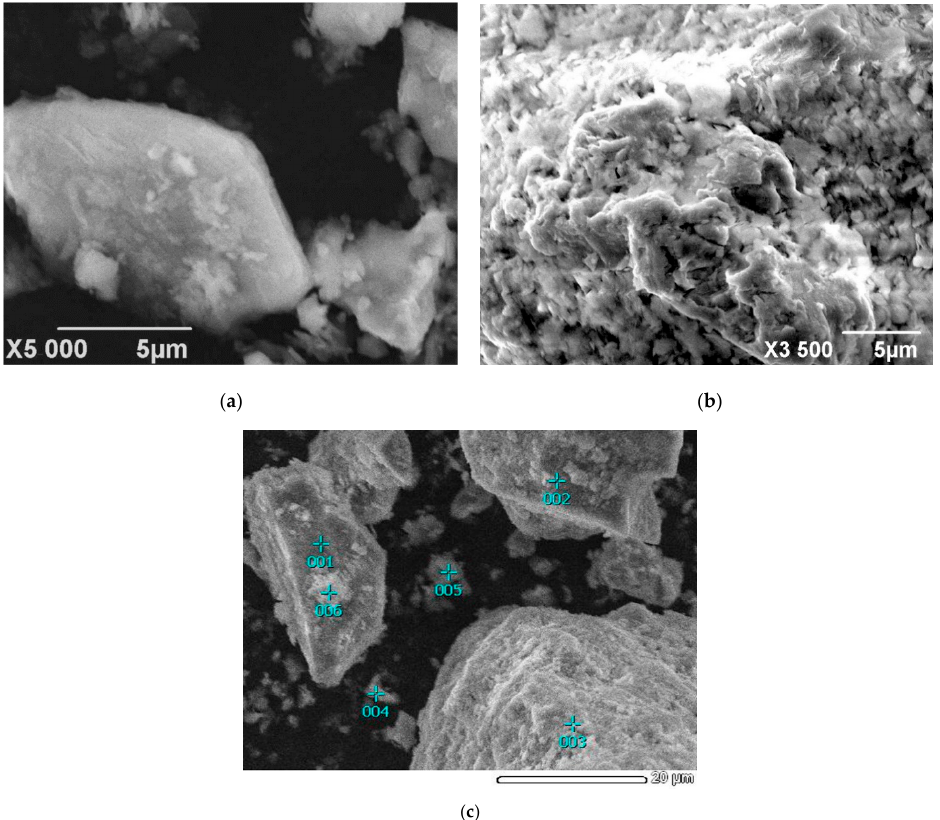
Figure 5. SEM images of typical grains of the initial concentrate ( a , b ) and SEM image with the position of an EDX spectrum ( c ). Table 4. The elemental compositions (energy-dispersive X-ray spectroscopy analysis (EDX) spectrum) of the initial concentrate, wt. %.